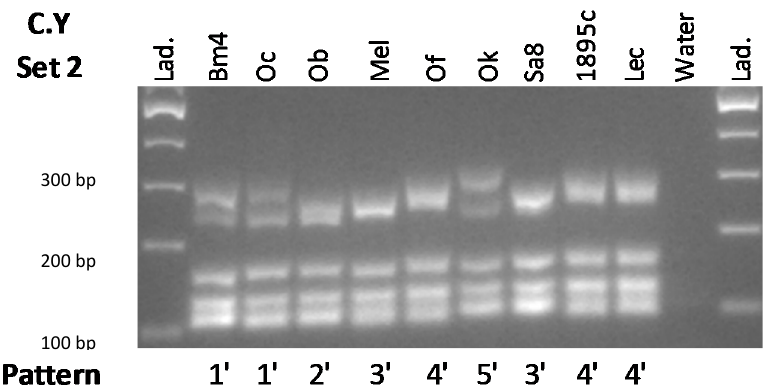
Figure 3. Results of the gel electrophoresis for the commercially available yeasts named above after multiplex PCR using Multiplex Set 2 with the patterns numbered from 1–5.